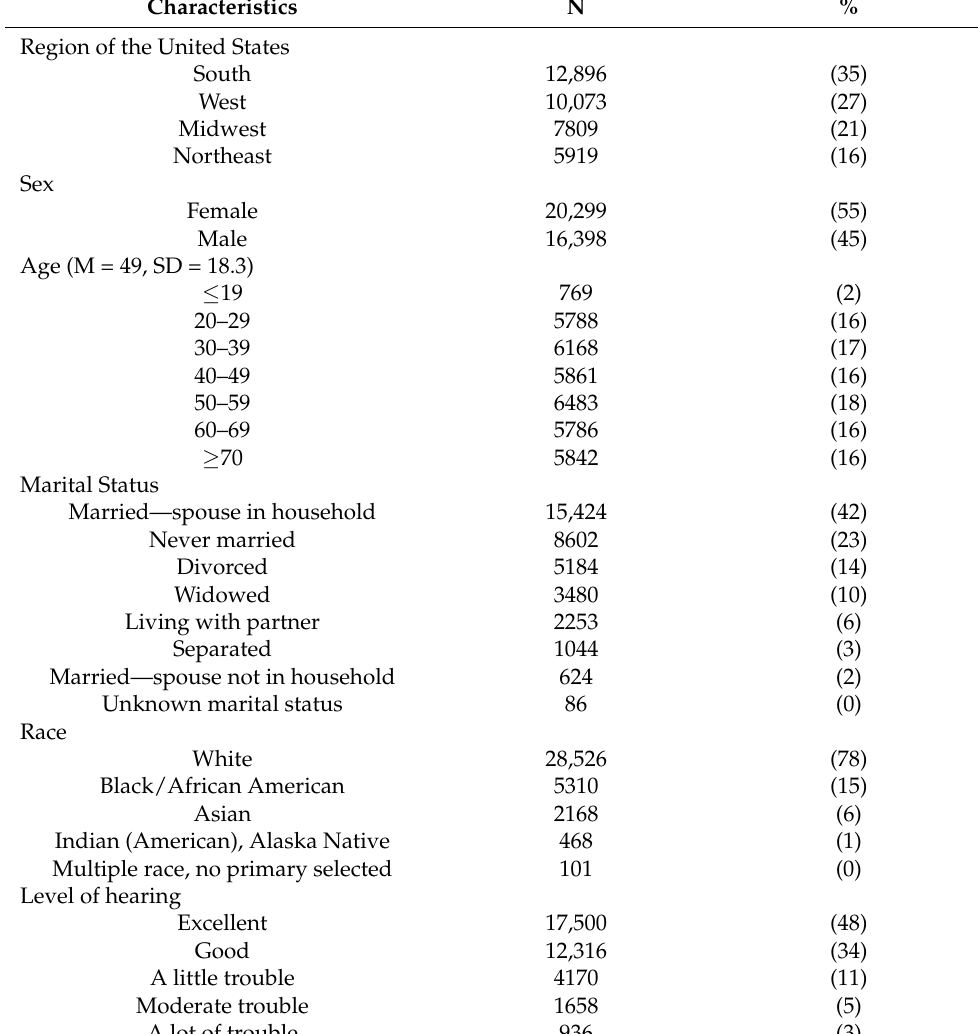
Table 1. Participant demographics: all National Health Interview Survey (NHIS) participants